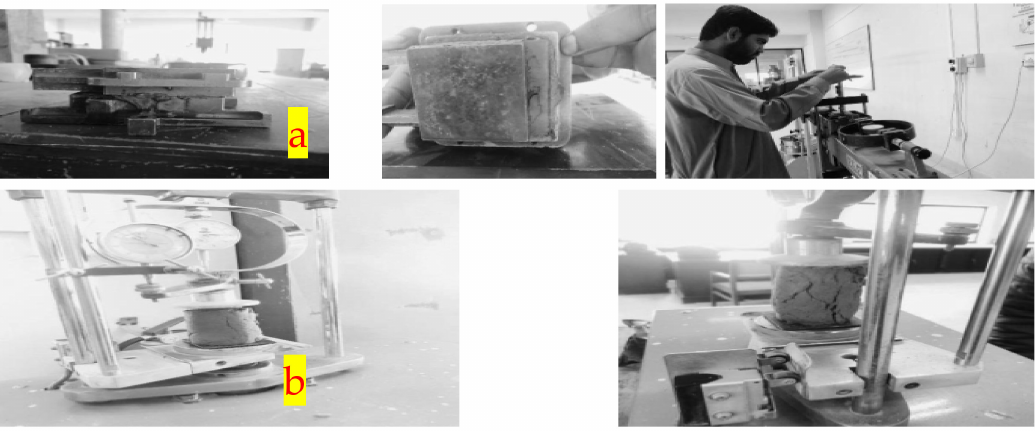
Figure 2. Illustration of laboratory work: ( a ) shear strength test; ( b ) un-confined compression